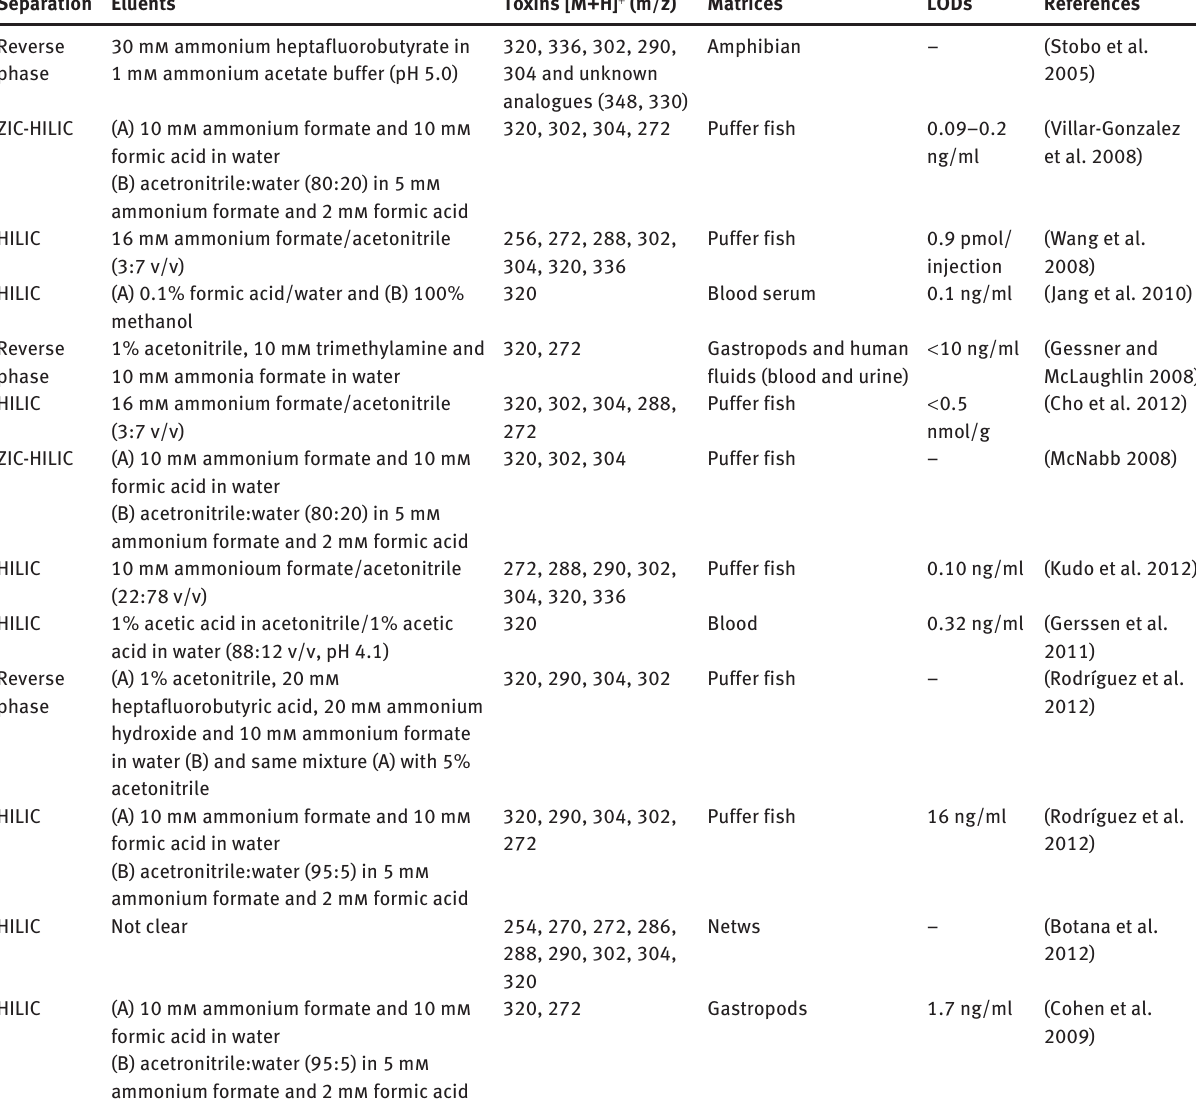
Table 2 Summary of several LC-MS/MS methods to detect TTX and its